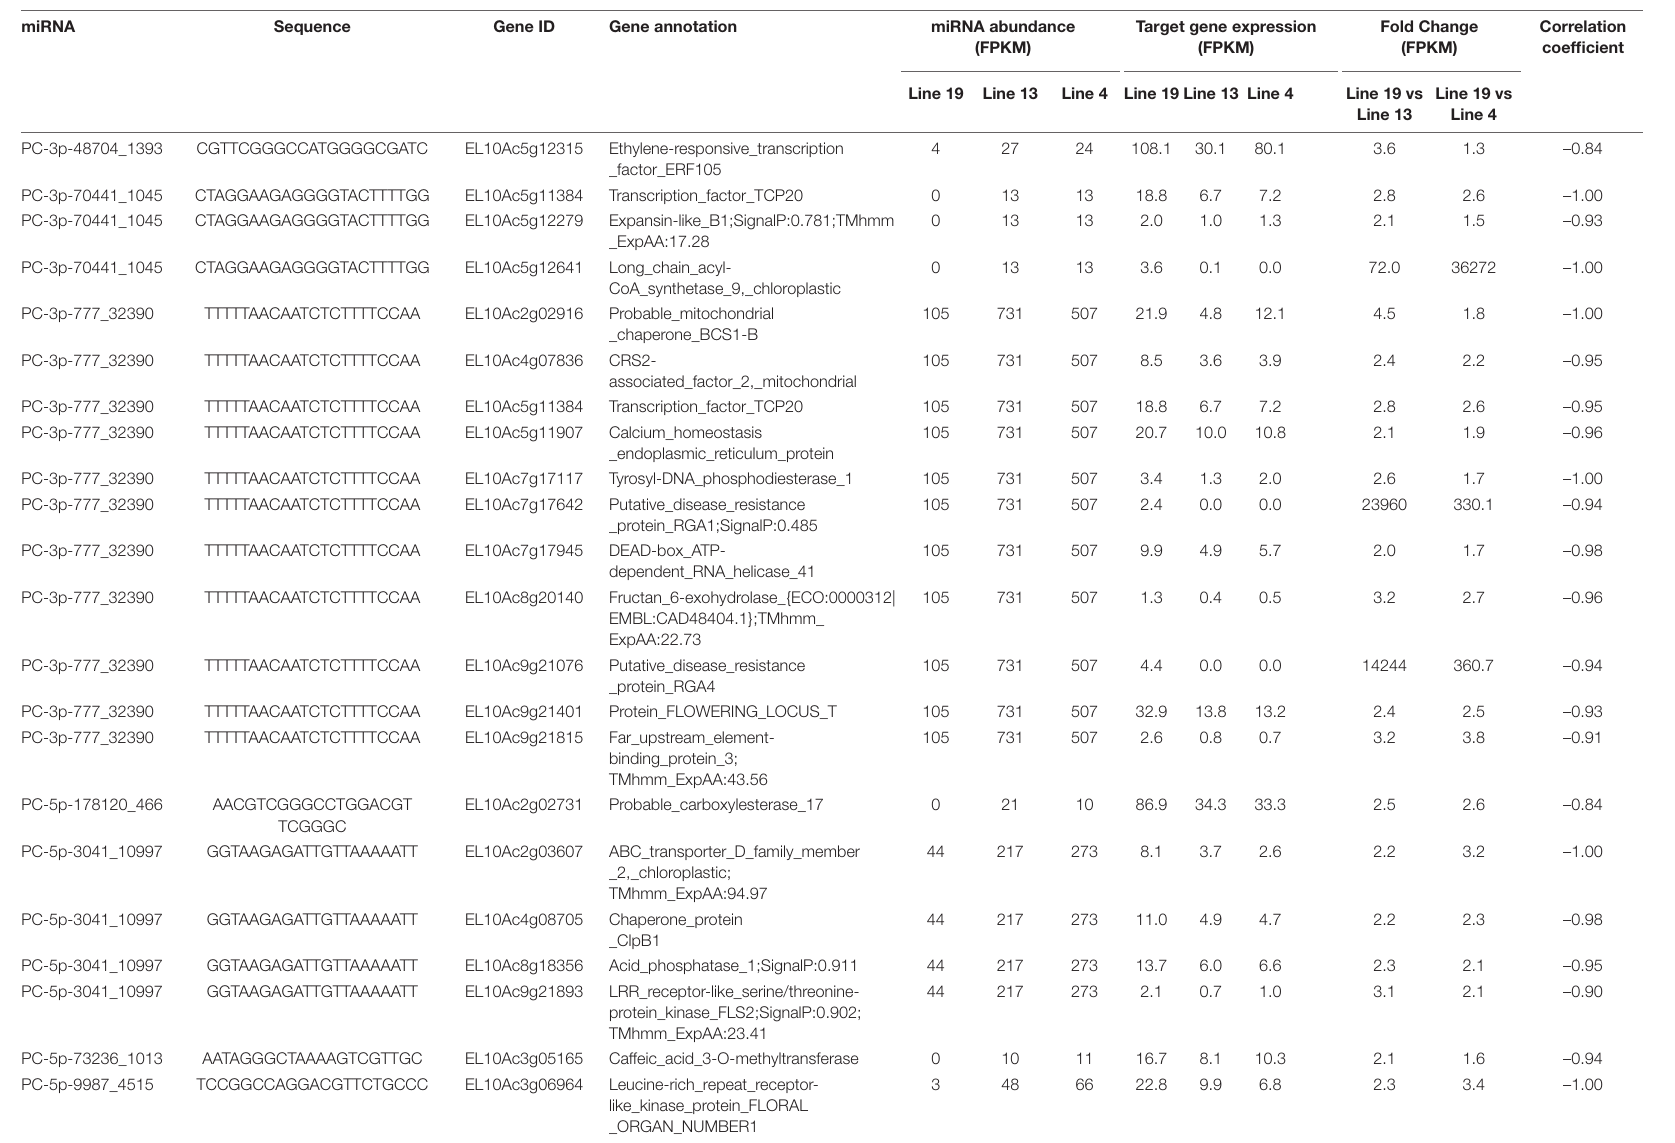
TABLE 3 | Sugar beet miRNAs that showed > 4-fold expression in the apical leaves of BCTV resistant (13, 4) vs. susceptible (19) lines at 6 dpi and effect on corresponding sugar beet target gene expression.